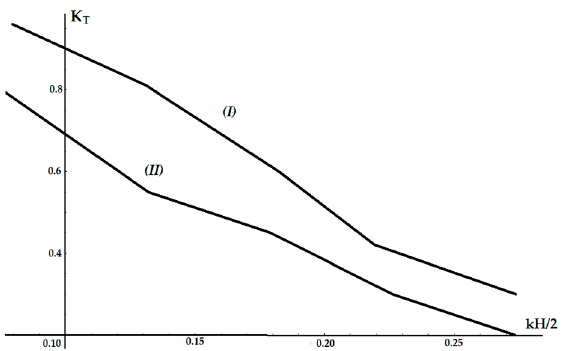
Figure 16. Wave transmission coefficient K T = H T / H I in dependence of incoming wave steepness kH /2 . Curve (I)—latex, curve (II)—polyvinyl chloride (PVC).